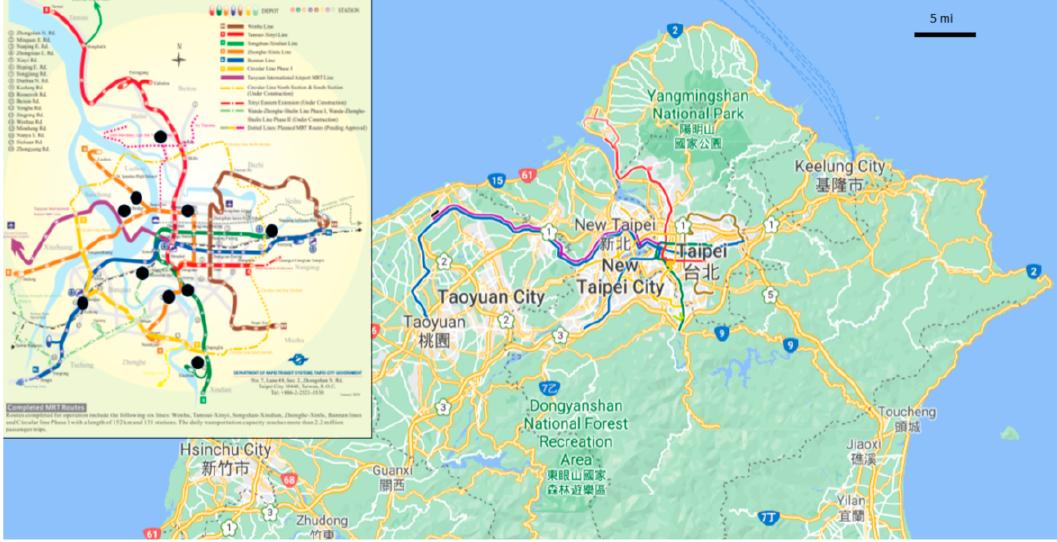
Figure 1. A map of northern Taiwan showing the location of Taipei City and New Taipei City. The inset is an enlarged map of the Metro lines. The black dots are the approximate locations of the EPA monitoring